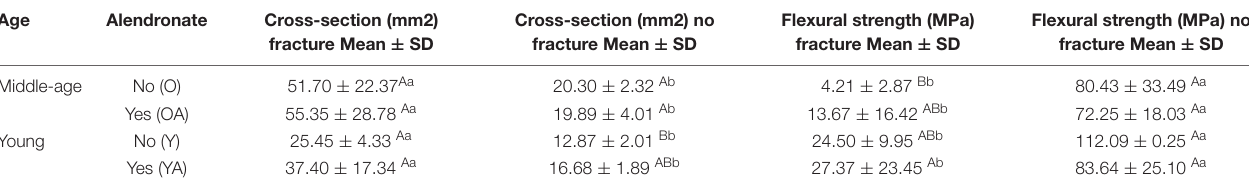
TABLE 3 | Evaluation for cross-section and flexural strength related to age and presence or not of